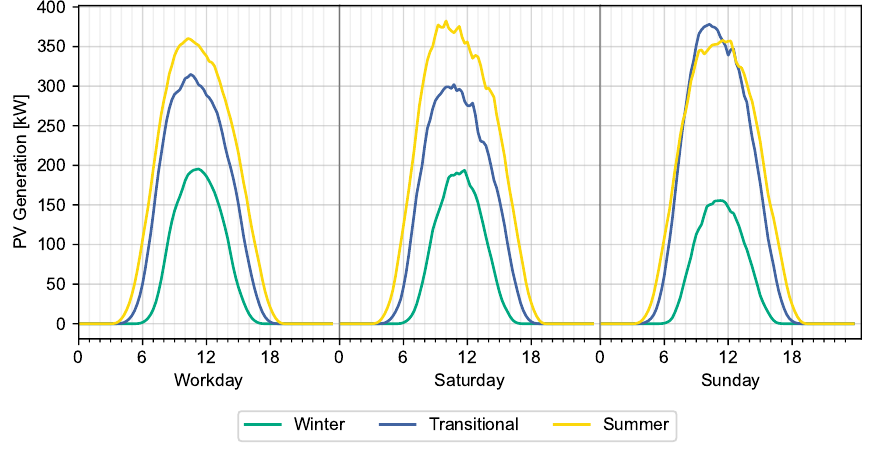
Figure 7. Mean PV generation of all 100 PV systems per day